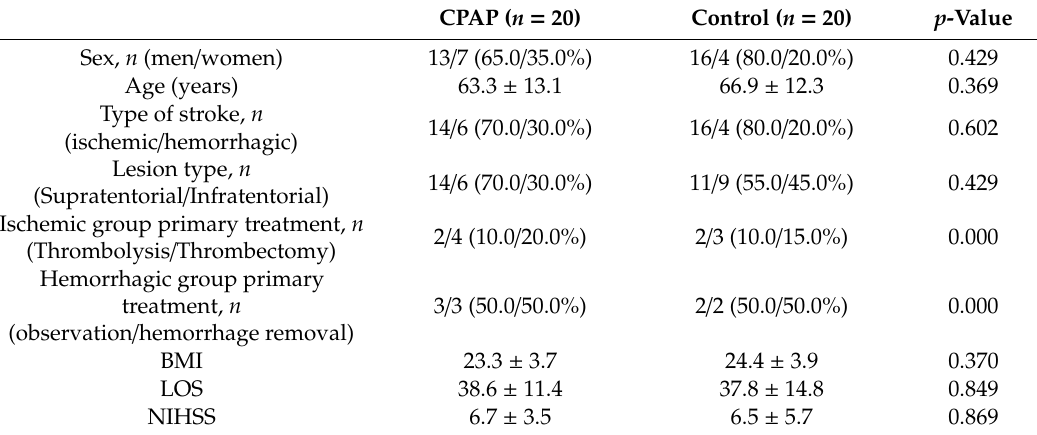
Figure 1. Flow chart to study population. PSG, polysomnography; OSA, obstructive sleep apnea; CPAP, continuous positive airway pressure. Table 1. Clinical characteristics of intervention group.